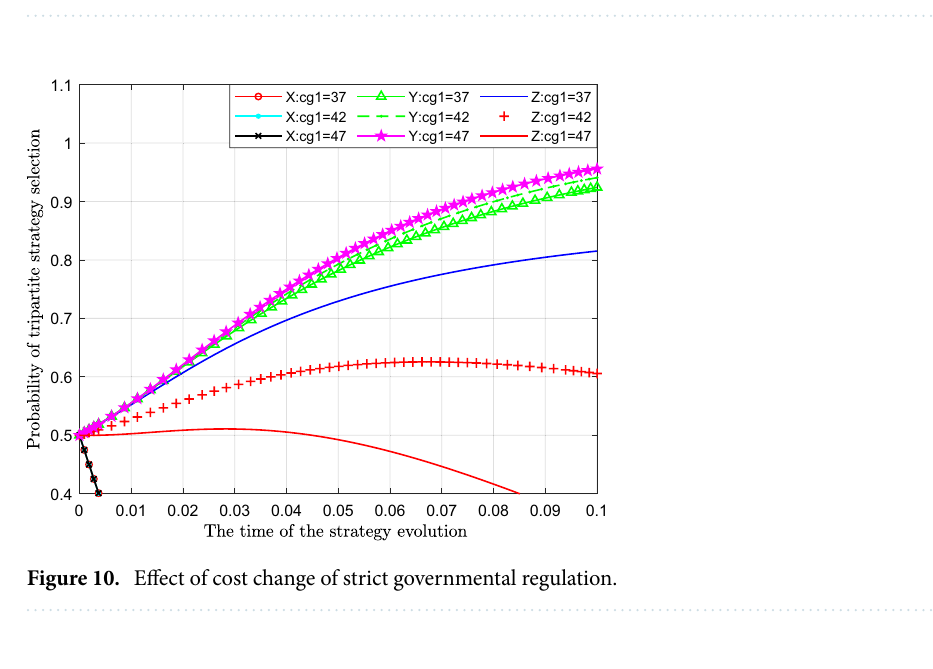
Figure 9. Effect of the change in reward on the public’s participation in supervision.